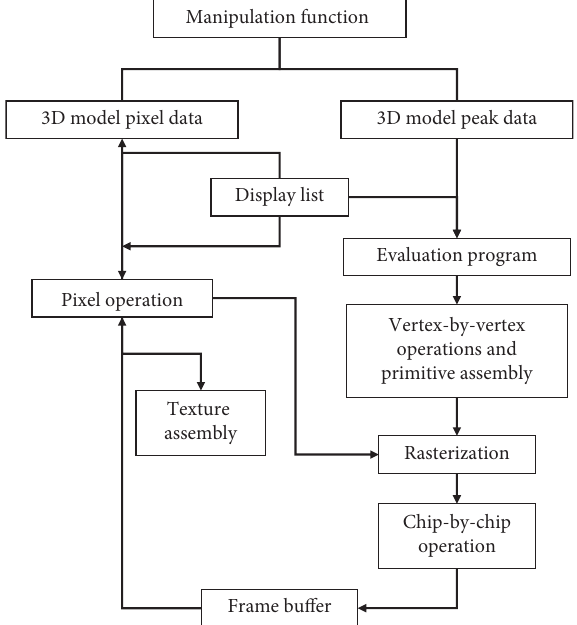
Figure 8: The information visualization model of the 3D